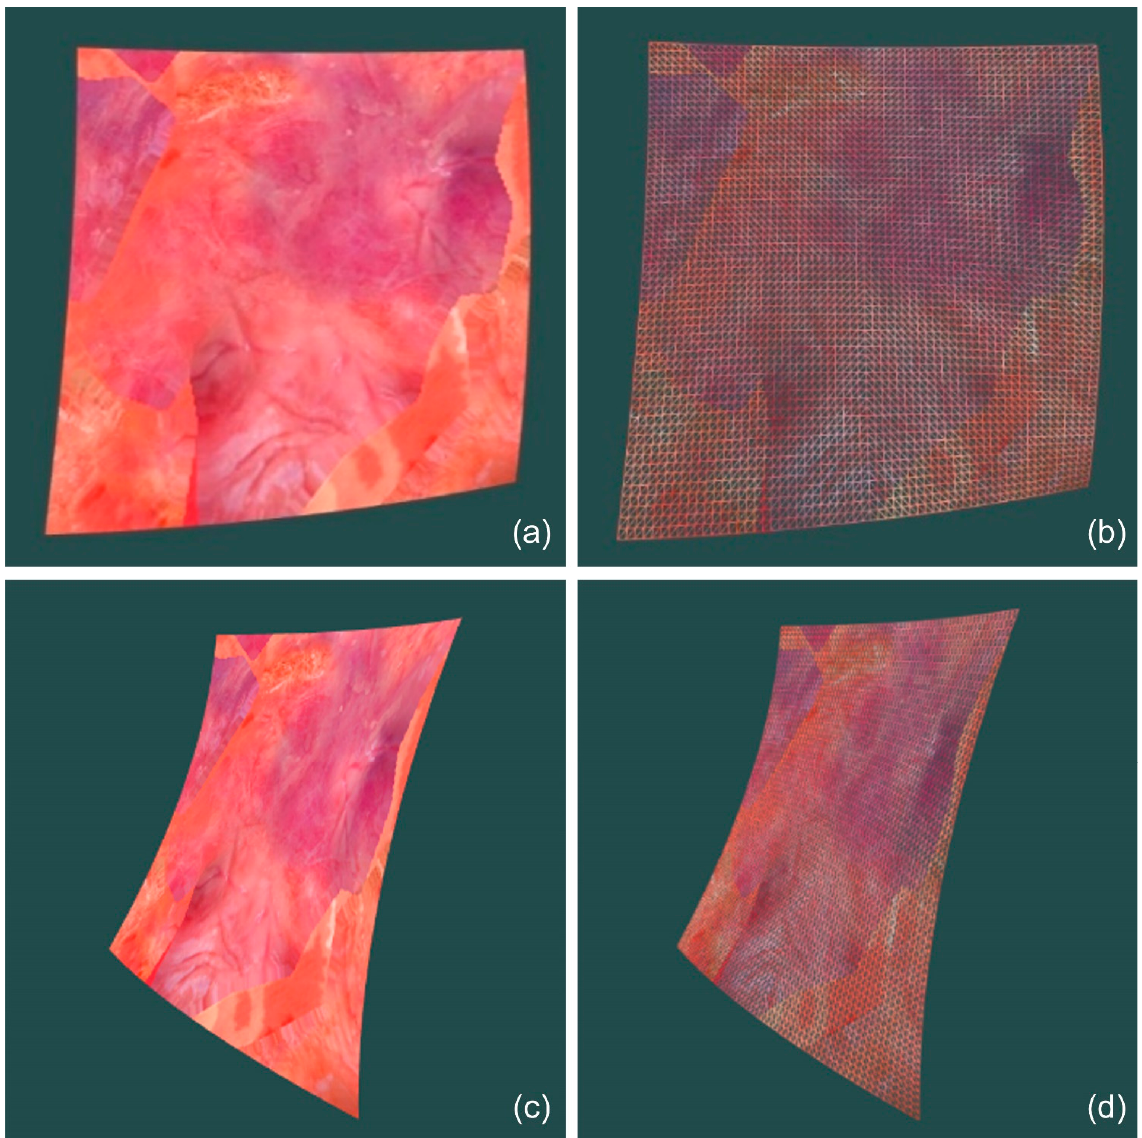
Figure 7. Effect drawing of the refined model: ( a ) effect of single frame thinning of the front view model, ( b ) effect of single frame thinning of the elevation point model, ( c ) effect of single frame thinning of the side view model, and ( d ) effect of single frame thinning of the side view model.